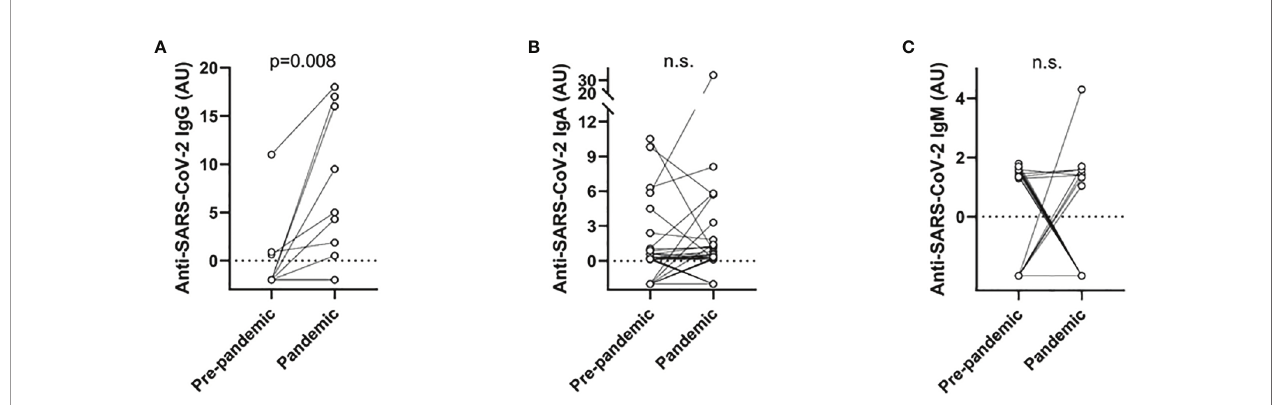
FIGURE 1 | Arbitrary units (AU) of SARS-CoV-2 antibodies in the sera of the 100 included patients with SLE demonstrated for each isotype: IgG (A) , IgA (B) , and IgM (C) before and during the pandemic. Only SARS-CoV-2 IgG levels were signi fi cantlyhigher duringthe pandemic compared with prepandemic samples. n.s.,not signi